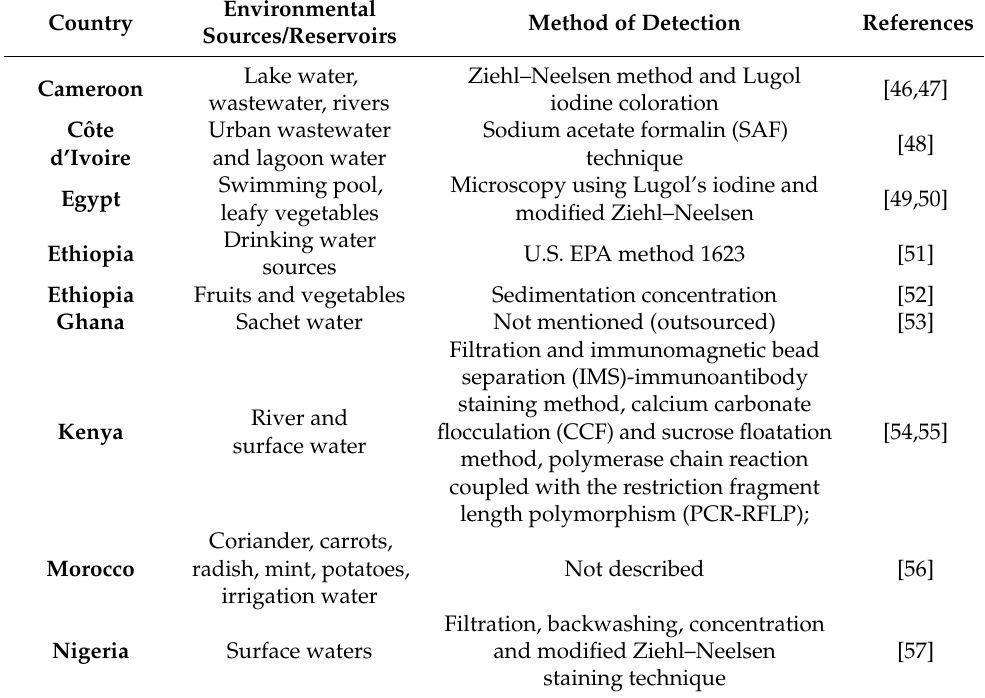
Table 3. Some environmental reservoirs of Cryptosporidium in